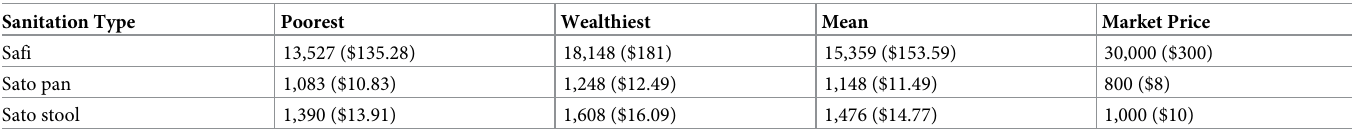
Table 2. Mean estimates for willingness to pay for sanitation in the study